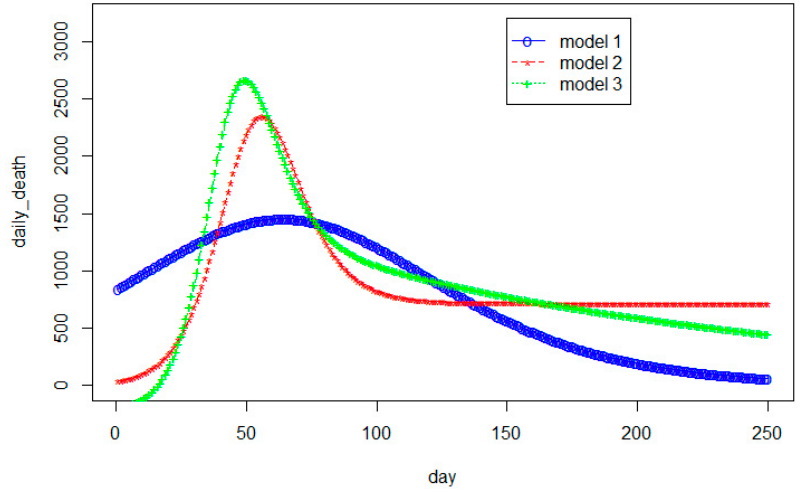
Figure 5. The estimated daily number of deaths over time for the United States. Table 2. Model comparison and ranking results using the model selection criteria based on the available data for the United States. Selection Criteria